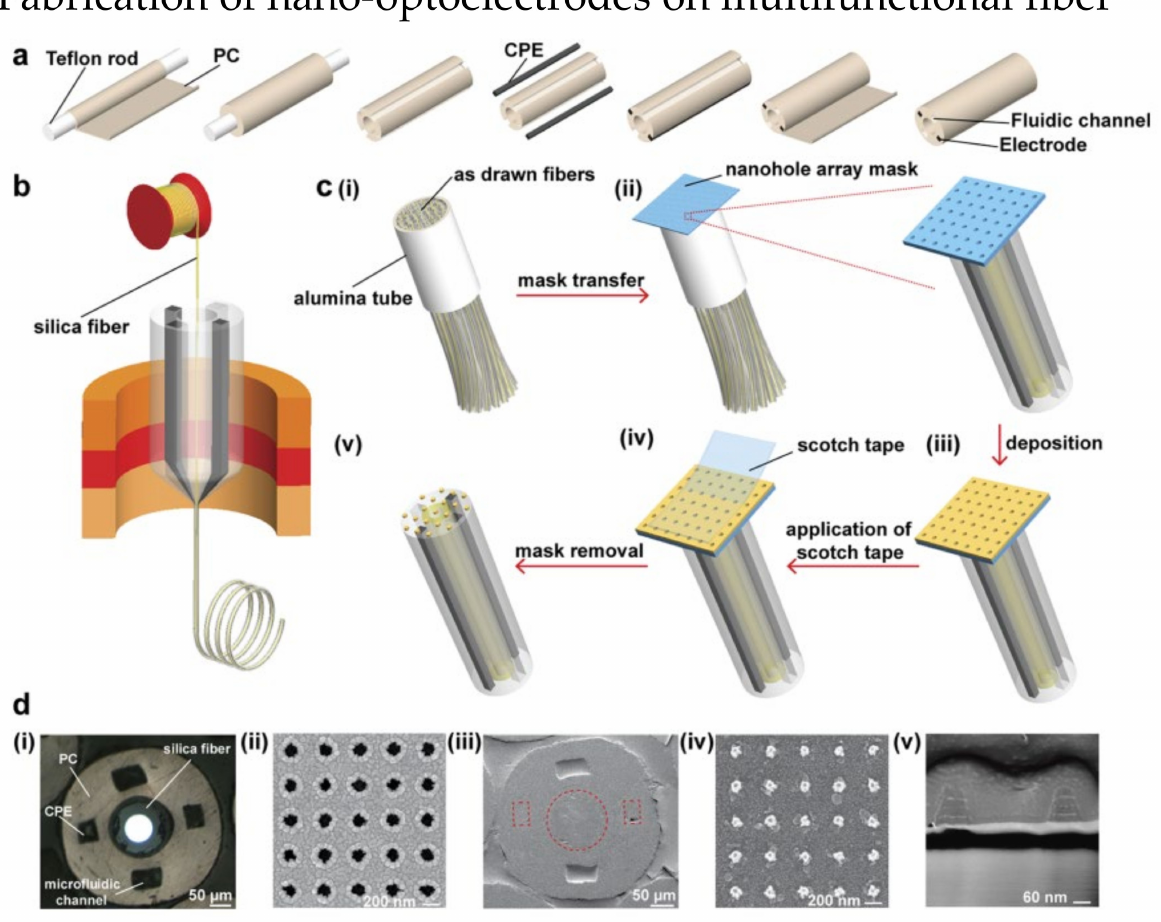
Figure 16. Fabrication steps of nano-optoelectrodes on multifunctional fiber probe. ( a ) Fabrication of preform with two conductive polymer electrodes (CPE) and two optofluidic channel. ( b ) A silica fiber was inserted into the hollow core of the preform before the fiber drawing process. ( c ) The process of combining nano − optoelectrodes on the fiber tips. ( i ) multiple fibers were packed together in an alumina tube and cut. ( ii ) After the top surface of fiber bundle was polished, a nanohole array mask was placed on it. ( iii ) Layers of Ti, Au, and Ag were deposited to the fiber bundle. ( iv ) A scotch tape was used to remove the nanohole array mask. ( v ) The final fiber with nanostructures. ( d )